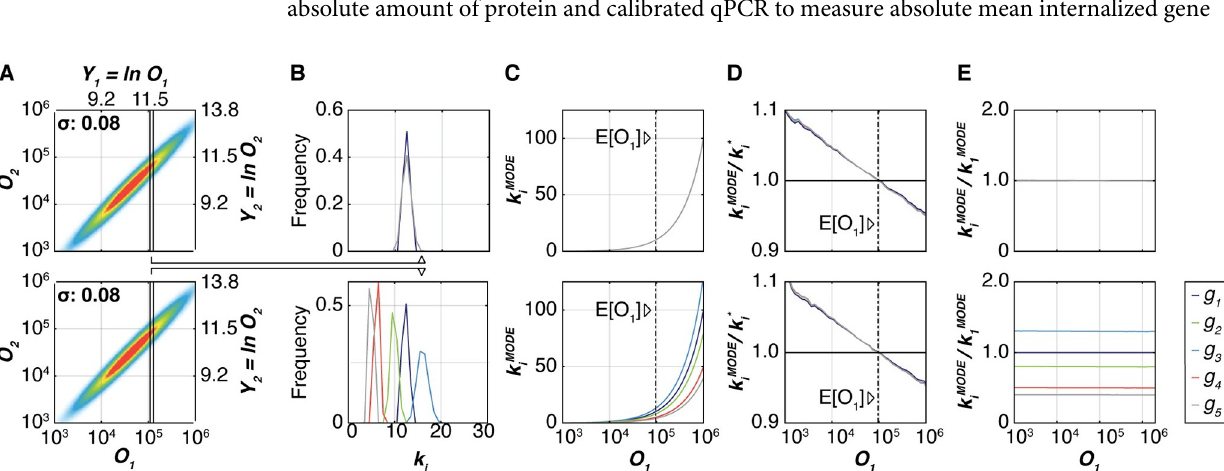
Fig 1. In-silico simulation of multiple gene co-transfections. In-silico simulations shown for two cases with parameter settings σ = 0.08, ε = 0.04 and m = 10: equimolar ( a 1 : a 2 : a 3 : a 4 : a 5 = 1.0: 1.0: 1.0: 1.0: 1.0; top row) and "nominal" ( a 1 : a 2 : a 3 : a 4 : a 5 = 1.0: 1.3: 0.8: 0.5: 0.4; bottom row) ratio of gene mix. (A) Density plots show the amount of expressed proteins O 2 versus O 1 . Solid black lines indicate the edges of an example bin for the transfection reference protein O 1 . (B) The plots show the distribution of gene copy numbers in cells whose O 1 values fall into the bin shown in panel A. Copy number distributions corresponding to different genes g i are shown using different colors (legend on the very right of the figure). In the equimolar case, gene copy number distributions overlap, while in the "nominal" case they are separated. (C) The modes of the copy number distributions are plotted versus the median signal of the transfection reference protein O 1 in all bins (colored lines). The dash-dotted line marks the mean ( E [ O 1 ]) of the global O 1 distribution. (D) For each bin of the transfection reference protein O 1 , the modes of the gene copy number distributions from each gene g i are determined numerically. The ratio of the numerically-determined mode of the copy number distribution k MODE and the anticipated copy number k � are computed and plotted versus the corresponding O 1 values in individual bins. The i i global mean of O 1 is shown with a dash-dotted line. (E) Ratios of gene copy number modes k MODE relative to the gene copy number mode of the transfection i reference protein k MODE , as a function of the O 1 median value in the bins. 1